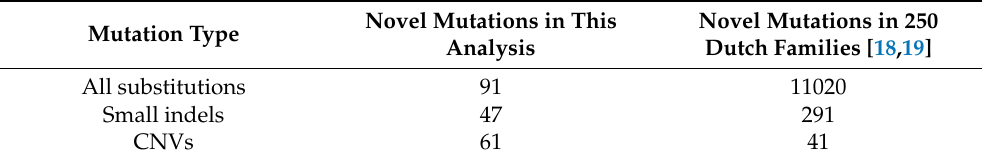
Table 3. Comparison of proportions between SNVs, indels, and large chromosome deletions observed in the PAX6 gene in Russian cohort of aniridia patients with the whole genome ratio. Novel Mutations in This Novel Mutations in 250 Mutation Type Analysis Dutch Families [18,19] All substitutions 91 11020 Small indels 47 291 CNVs 61